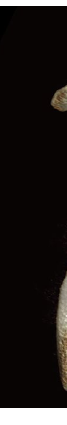
Figure 8. Estimation of measurement error.